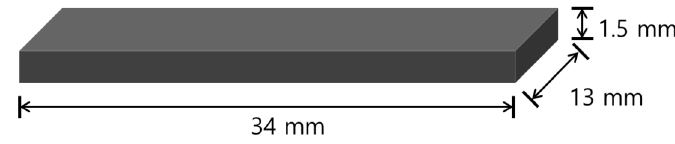
Figure 1. Schematic diagram of the shape of the alloy specimens. Table 1. Specifications of the materials used in this study.